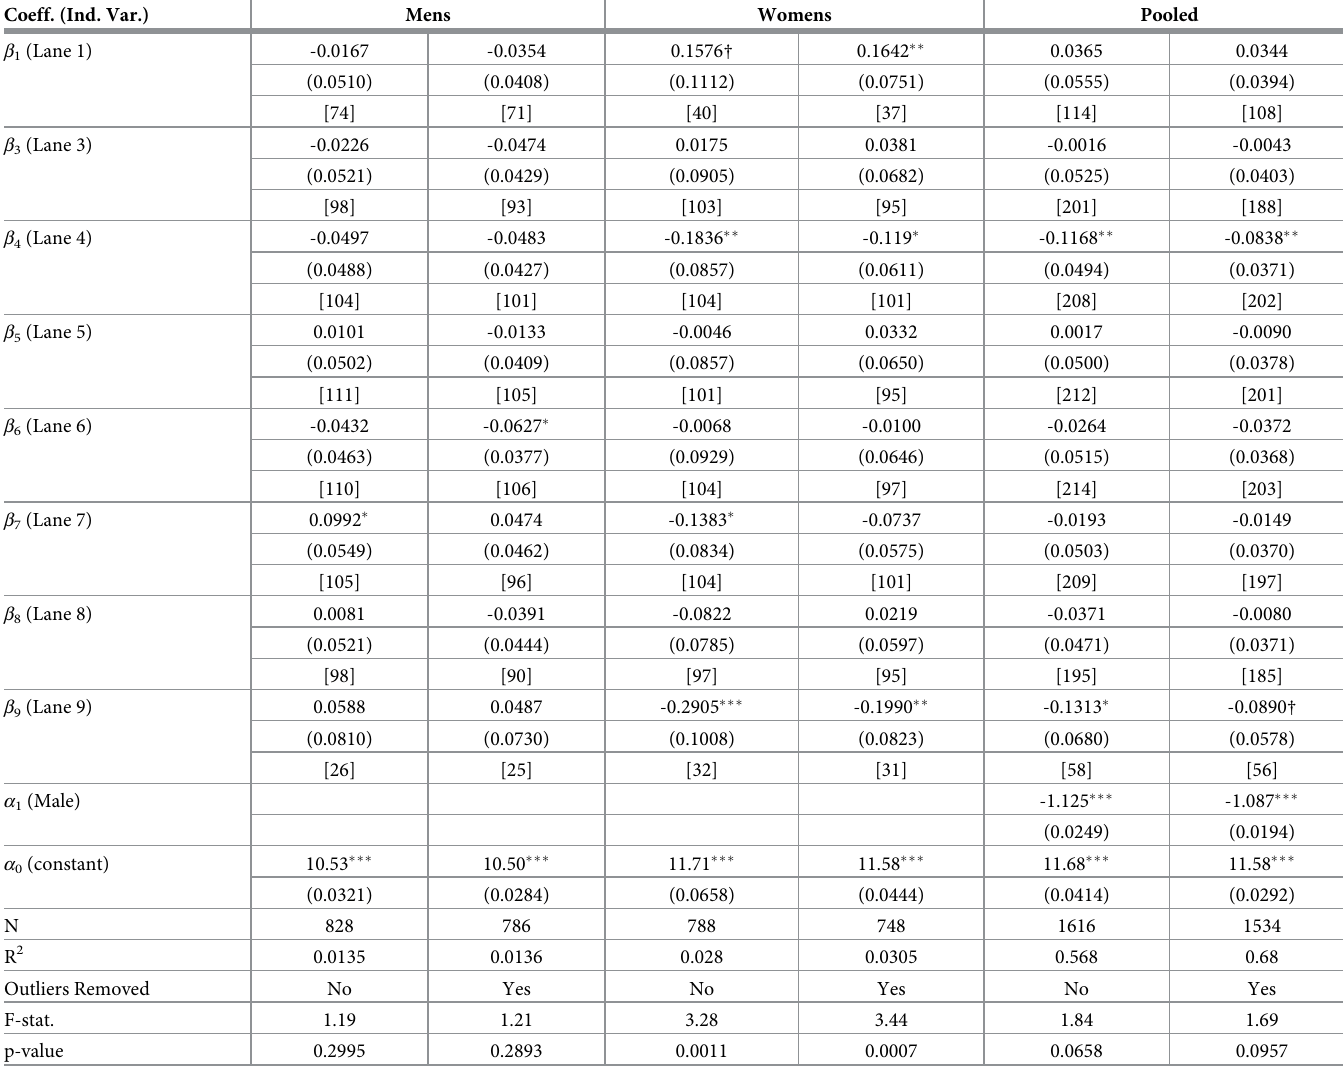
Table 1. Randomization check for 100m. Coeff. (Ind.